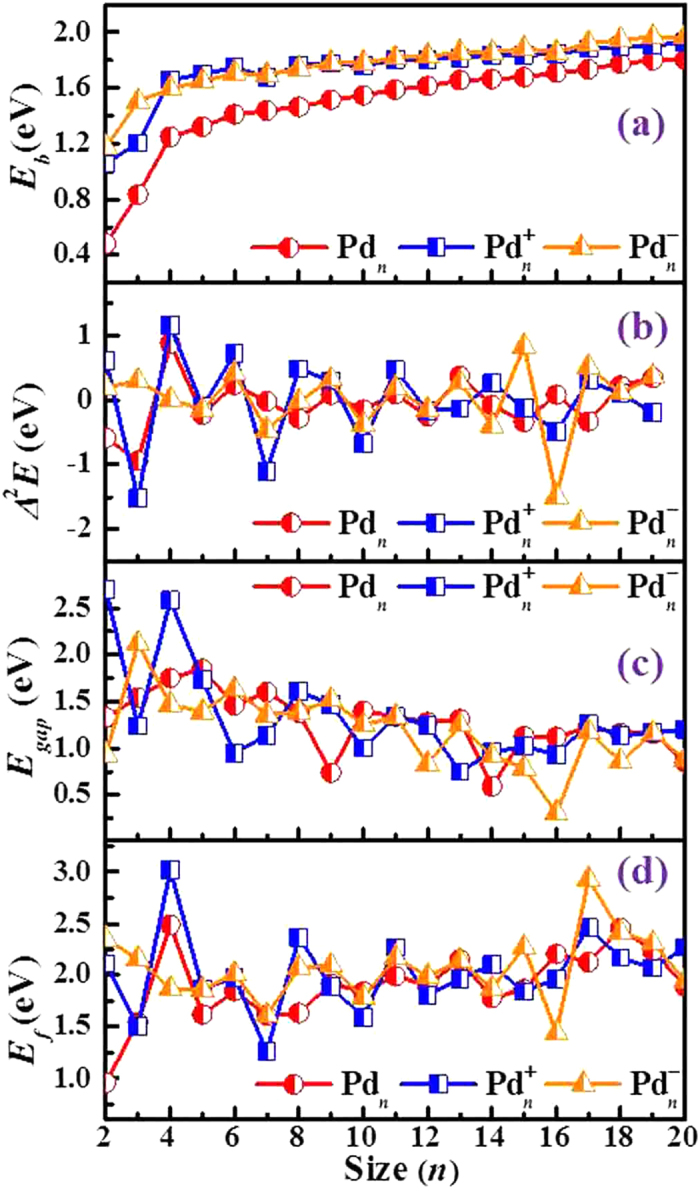
The binding energy per atom (Eb), second energy difference (∆2E), HOMO–LUMO gap (Egap), and fragmentation energies (Ef) of the preferred fragmentation channels for the lowest–energy Pdn0/+/– (n = 2–20) clusters.